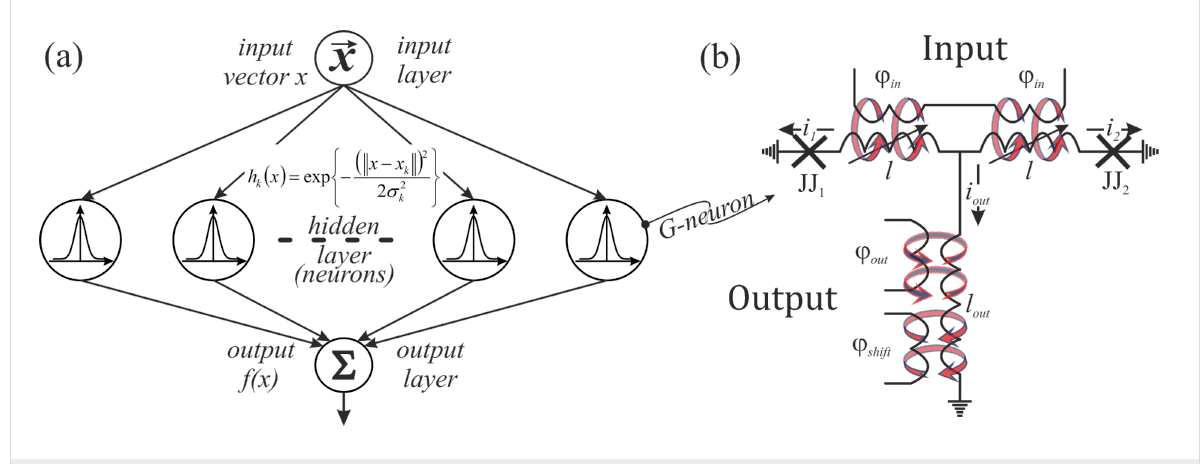
Figure 1: (a) Schematic illustration of a RBF network. (b) Schematic representation of a Gauss-neuron ensuring a Gauss-like transfer function.